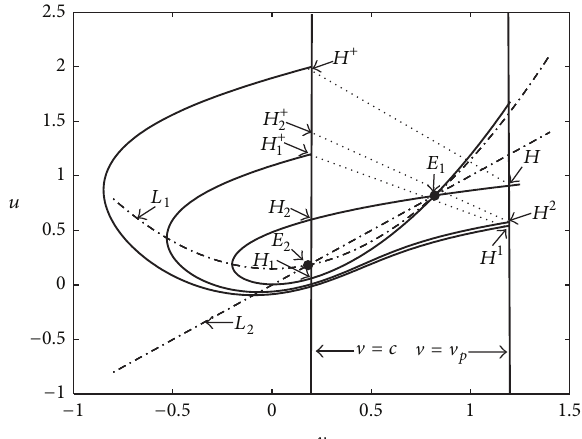
Figure 4: Location of the periodic solution of system (2) for case ) when V ≤ 𝑐 ≤ V (𝐴 1 4 1